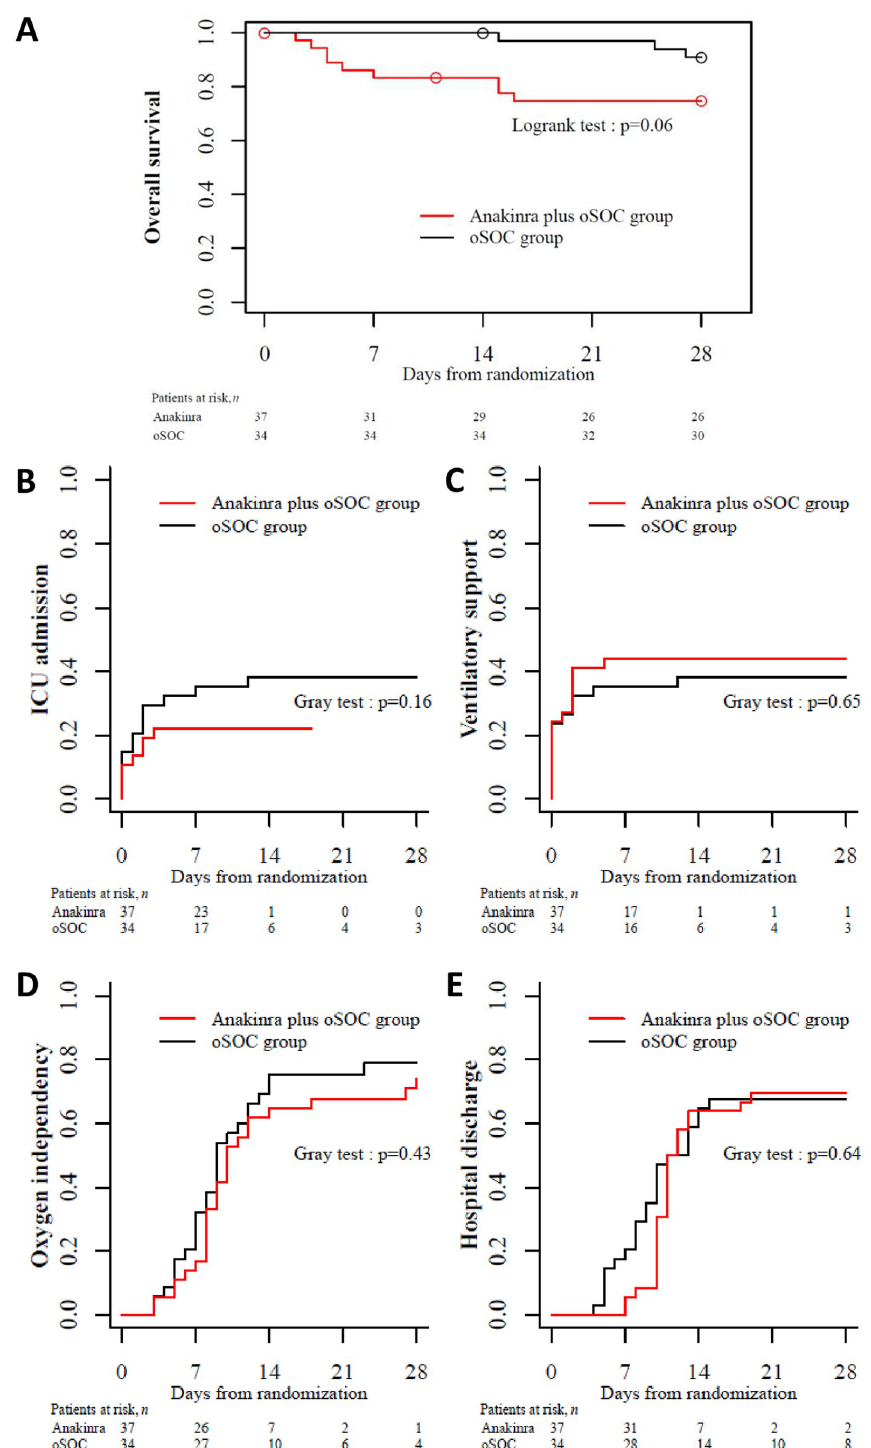
Fig 2. Secondary outcomes for analyzed patients over 28 days’ follow-up. A , Overall survival; B , Cumulative incidence of ICU admission; C , Cumulative incidence of need for ventilatory support; D , Cumulative incidence of oxygen independency; and E , Cumulative incidence of hospital discharge. ICU, intensive care unit; oSOC, optimized standard of care.